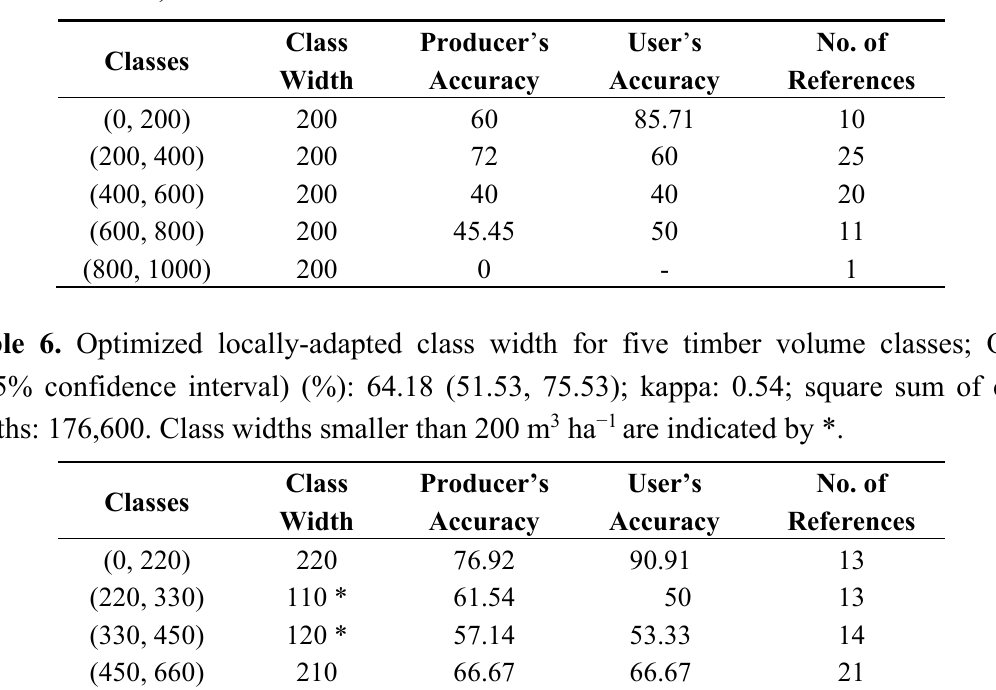
Table 5. Constant class width of 200 m 3 ha − 1 (five timber volume classes); OAA (±95% confidence interval) (%): 55.22 (42.58, 67.4); kappa: 0.36; square sum of class widths: 200,000.